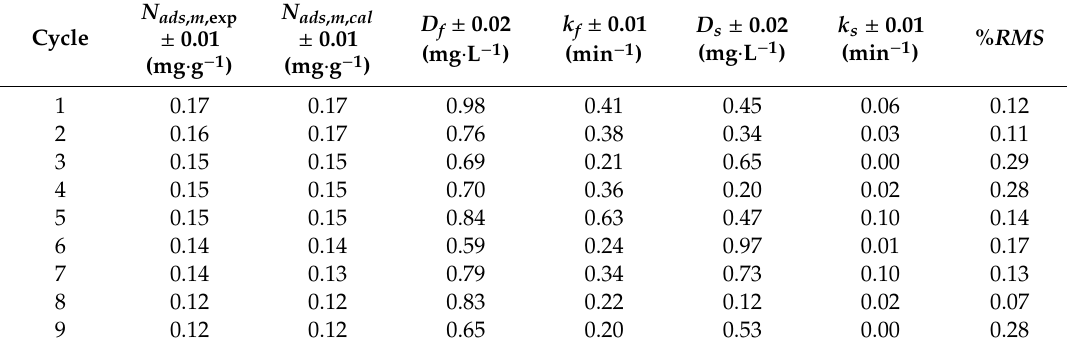
Table 1. Estimated values of the parameters of the double exponential model of n -C 7 asphaltene adsorption kinetics on CeNi0.89Pd1.1 nanoparticles through catalyst regeneration cycles of adsorption and subsequent catalytic steam gasification. The parameters are the amount adsorbed ( N ads , m , cal ), the adsorption ( D f ) and mass transfer ( k f ) coe ffi cients for the fast stage, and the adsorption ( D s ) and mass transfer ( k s ) coe ffi cients for the slow stage, respectively. Adsorption kinetics were obtained for an initial n -C 7 asphaltenes concentration of 10 mg · L − 1